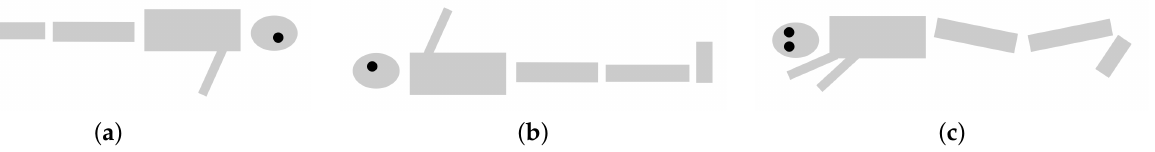
Figure 3. Illustration of people having fallen forward, backward or sideways: ( a ) fallen forward; ( b ) fallen backwards; ( c ) fallen